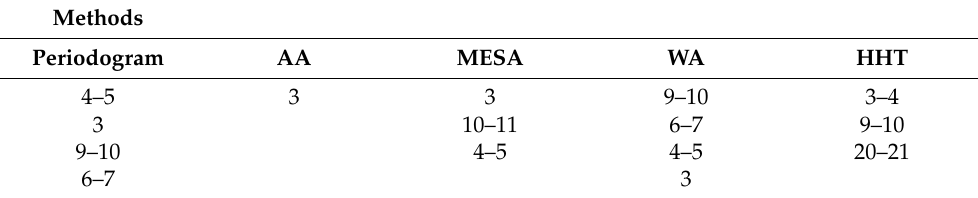
Table 6. The periods identified from annual series at Huayuankou station.